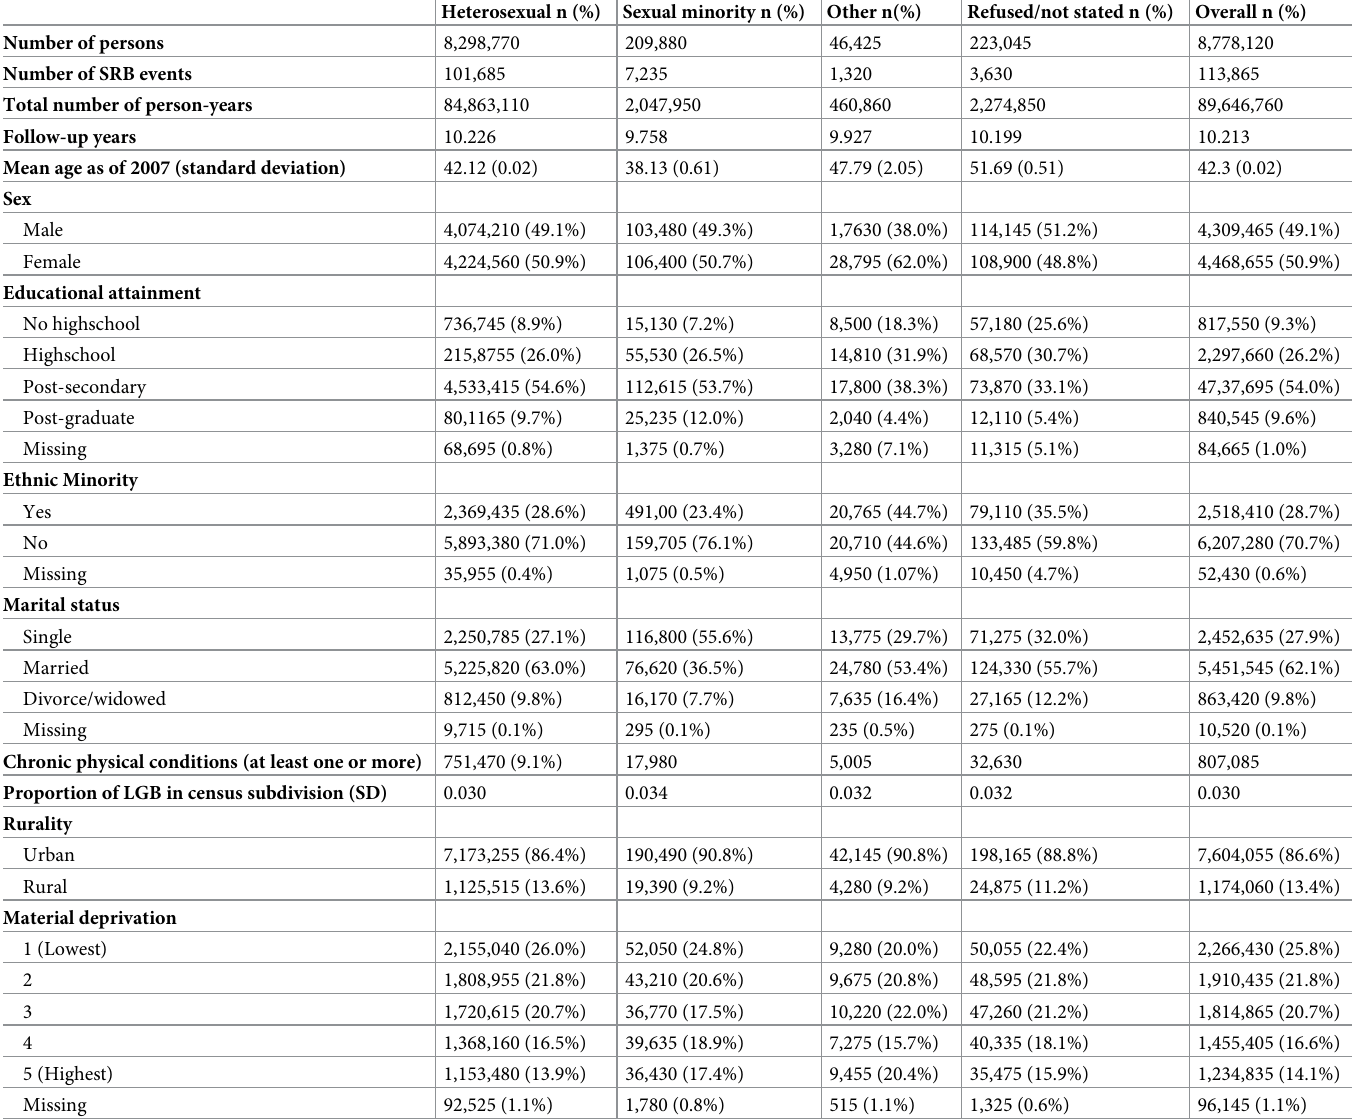
Table 1. Weighted sample characteristics at baseline among men and women aged 18+ in Ontario, Canada (unweighted n = 169,090; weighted n = 8,778,120